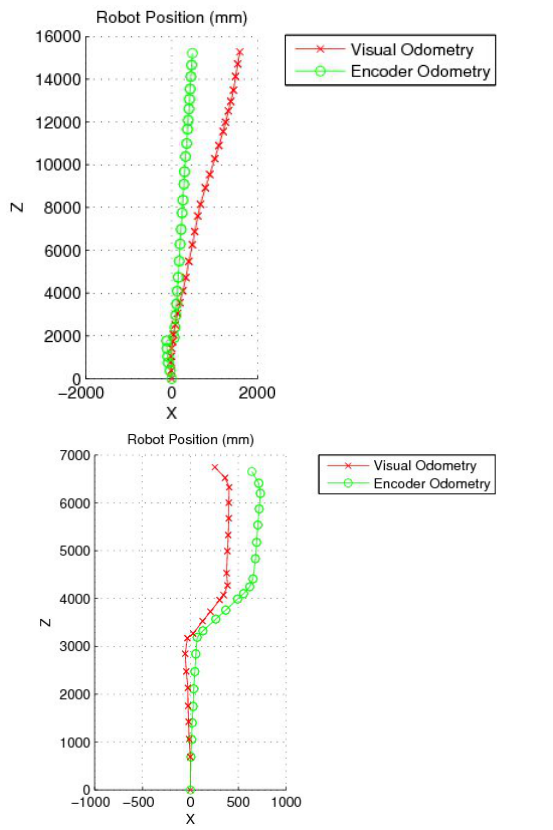
of the operation